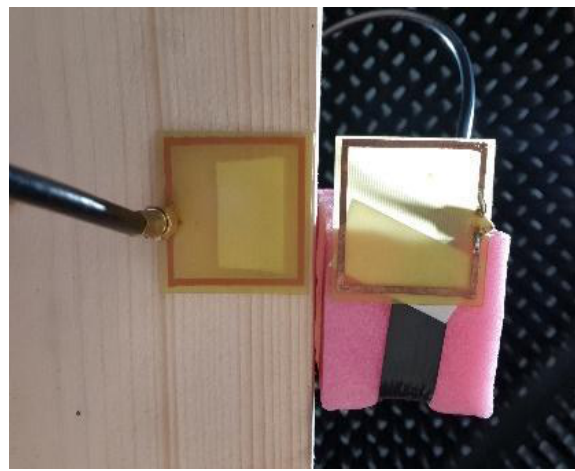
Figure 28. Loop antenna calibration. The gain and the effective area of the loop antenna are presented in Figure 29.